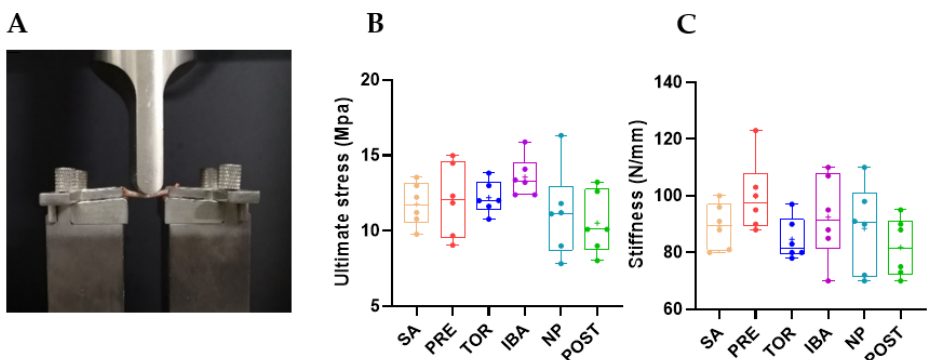
Figure 2. Comparison of femur mass in Daurian ground squirrels in different groups. Boxes repre- sent upper and lower quartiles, middle horizontal line represents median, plus sign represents av- erage, lines extending from upper and lower ends represent upper and lower edges, respectively, and points represent individual sample values ( n = 6). No superscript letters denote no significant differences among groups by Sidak test ( p > 0.05). SA, summer active group; PRE, pre-hibernation group; TOR, torpor group; IBA, interbout arousal group; NP, near post-hibernation group; and POST, post-hibernation group.